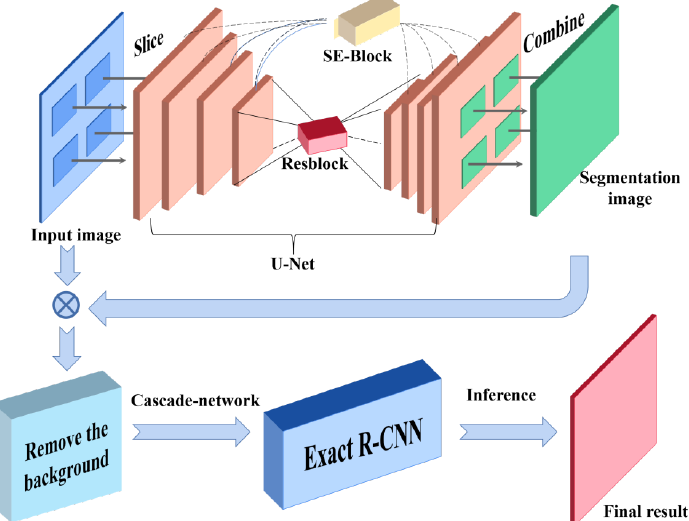
Figure 15. The general flowchart of our proposed CME-CNN (cascade the mask extraction and exact region-based convolutional neural network).